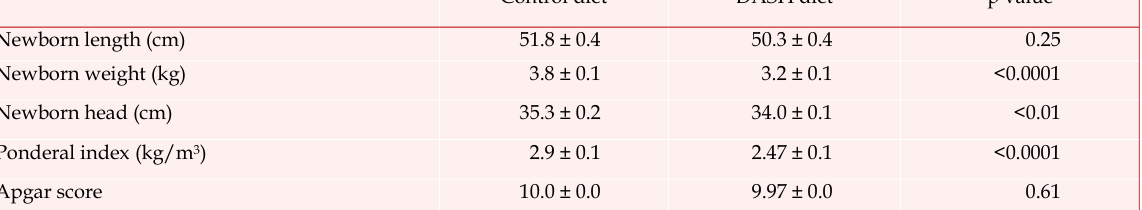
Effect of DASH diet on birth size of the newborns Control